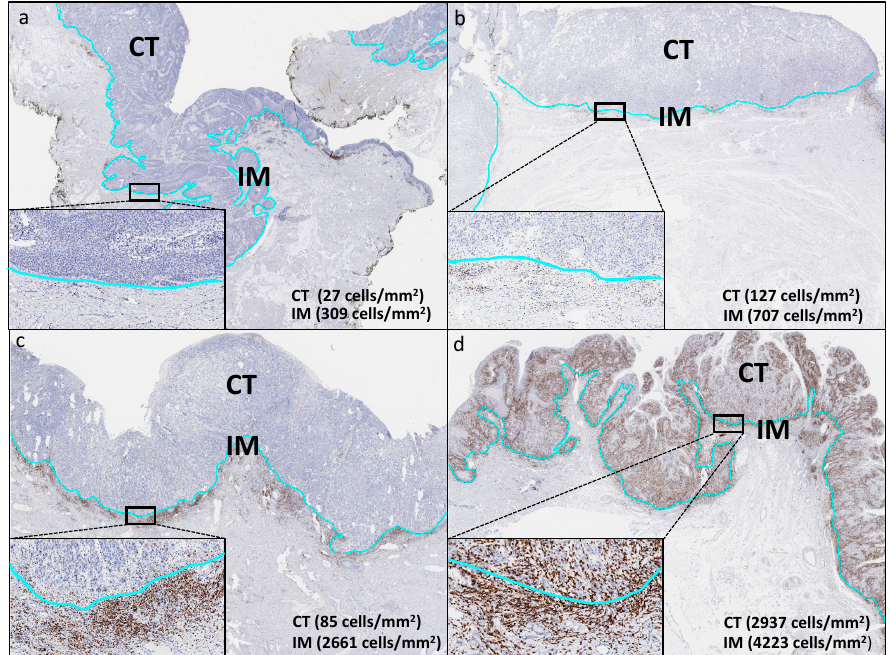
Figure 1. T-cell infiltration patterns in vulvar cancer. Representative images of an immune desert ( a ); immune excluded ( b , c ), and an immune inflamed phenotype ( d ) are depicted. The light-blue line indicates the invasive margin (IM) that represents the outer edge of the center of the tumor (CT). The images are taken at 5× magnification.